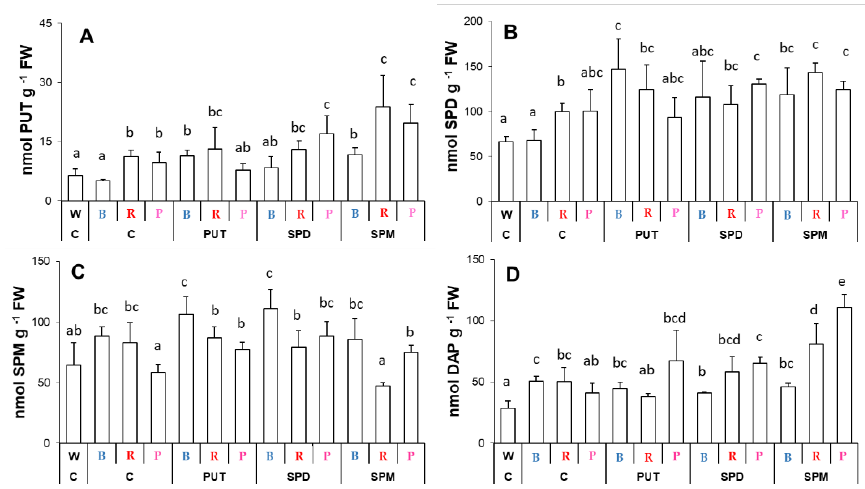
Figure 5. Polyamine contents (( A ): putrescine: PUT; ( B ): spermidine: SPD; ( C ): spermine: SPM; ( D ): 1,3-diaminopropane: DAP) in the leaves of plants grown under different light regimes (white light: W, blue light: B, red + far-red: R and the combination of blue and red + far-red, pink: P) treated with or without polyamines (control: C, putrescine: PUT, spermidine: SPD and spermine: SPM). Values are means ± SD ( n = 3). Different letters indicate statistically significant differences at p < 0.05 level, using Duncan’s post hoc test.